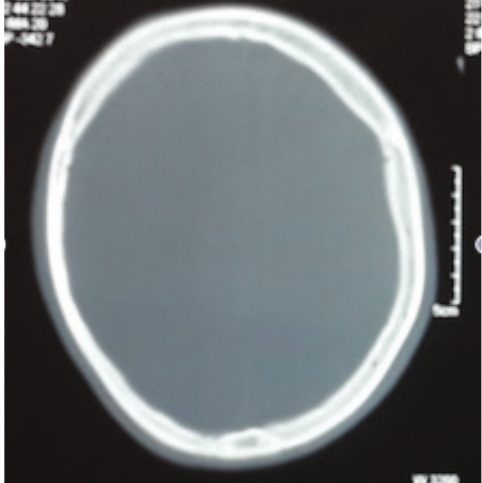
Figure 4: CT scan head showing thickening of skull on left